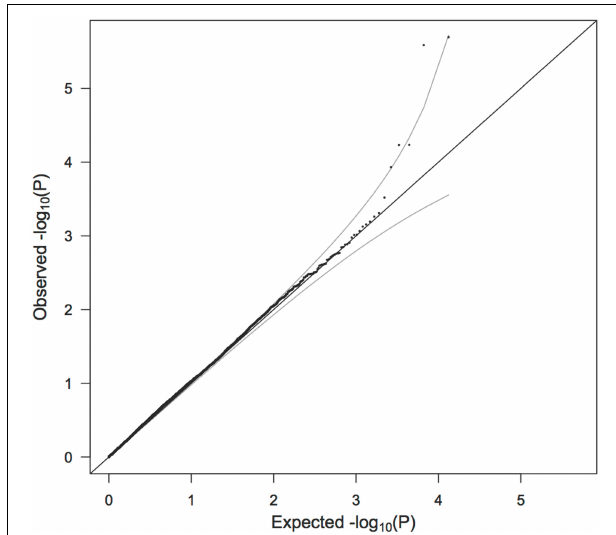
FIGURE 4 | QQ plot of − log 10 ( p ) as calculated from the test of parental allelic exchangeability. Ninety five percent confidence intervals are shown. Four SNPs (rs17269319, rs3747355, rs5906541, and rs12558269) are not shown because of extremely low p -values. No fathers carried the minor alleles for these four SNPs and the quality of genotyping consequently appears to be